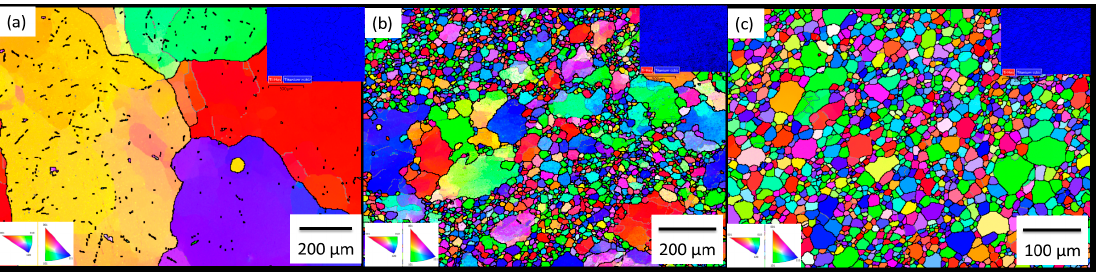
Figure 7. Electron backscatter diffraction (EBSD) maps of ( a ) Ti-154; ( b ) Ti-244; and ( c ) Ti334 specimens (the phase maps are shown in the inset).